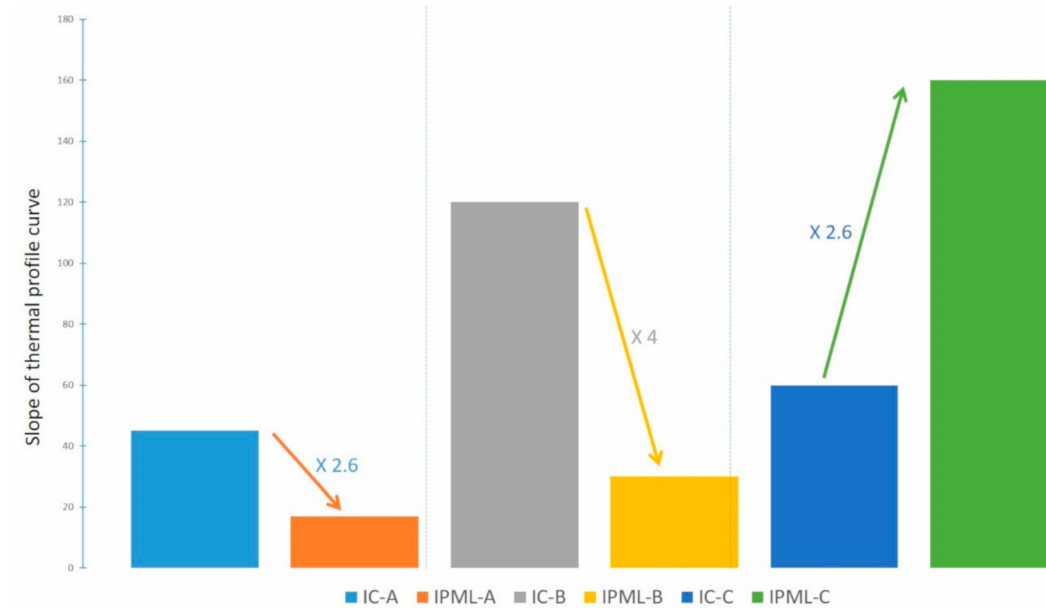
Figure 7. Slope comparison of thermal profile curve at the beginning of burn-through test.